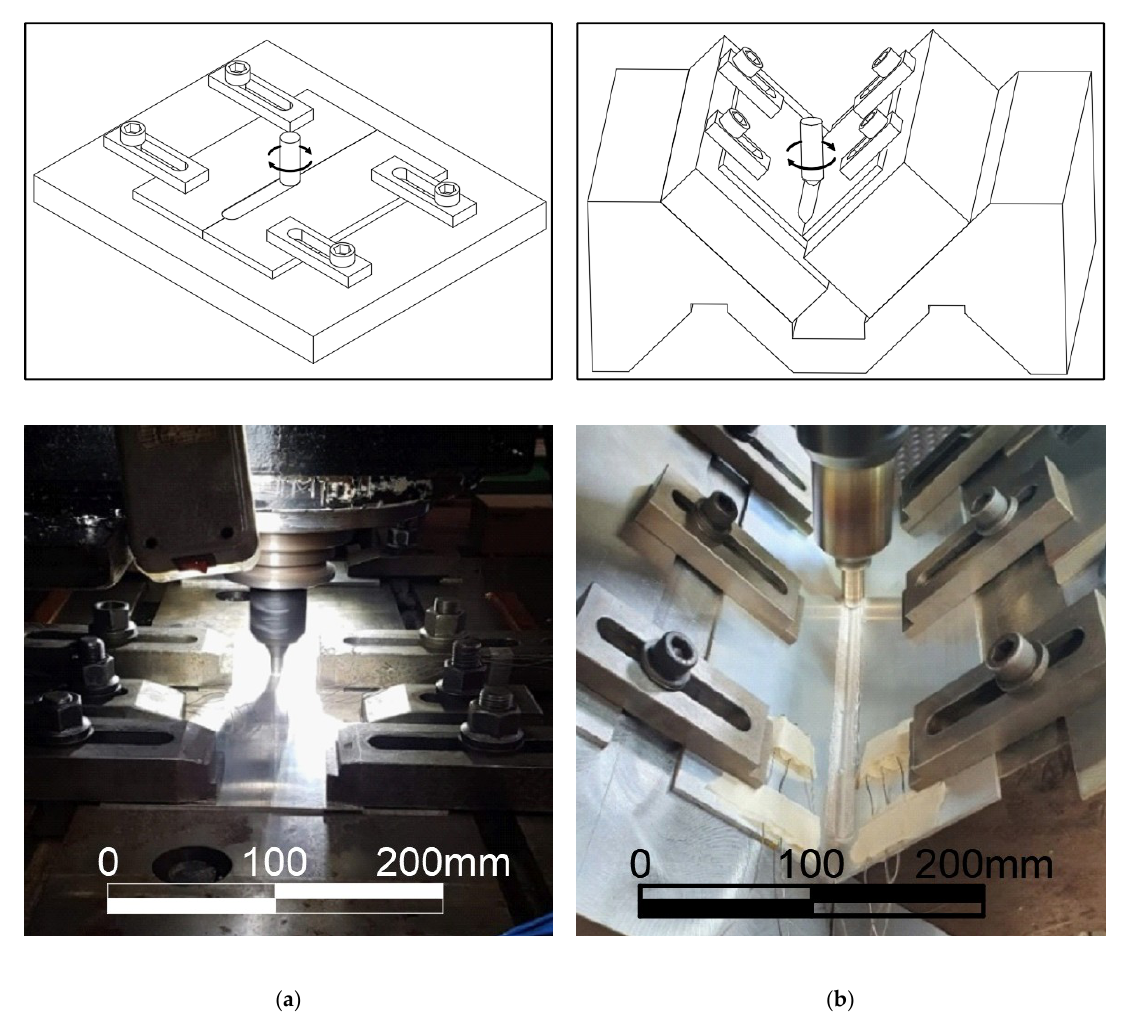
Figure 8. Experiment models: ( a ) Butt joint; ( b ) fillet joint.